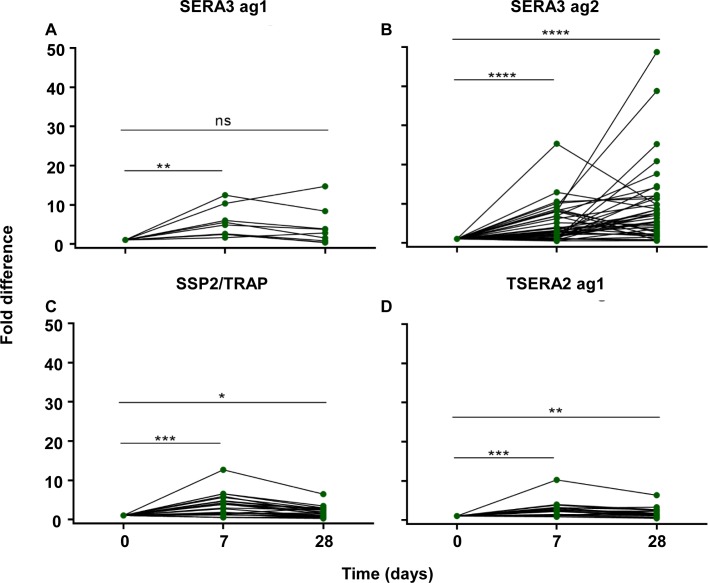
Serial fold increase in antibody reactivity for each antigen following treatment of knowlesi malaria.(a) SERA3 ag1, (b) SERA3 ag2, (c) SSP2/TRAP and (d) TSERA2 ag1. Asterisks indicate level of significance, ns denotes non-significant values (p≤0.0001 ****; p≤0.001 ***; p≤0.01 **; p≤0.05 * and p>0.05 ns).